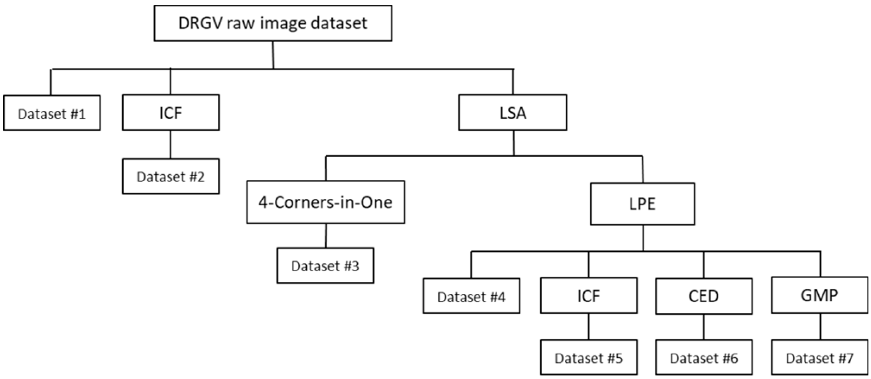
Figure 9. Flowchart of the pre-processed DRGV dataset generation process.